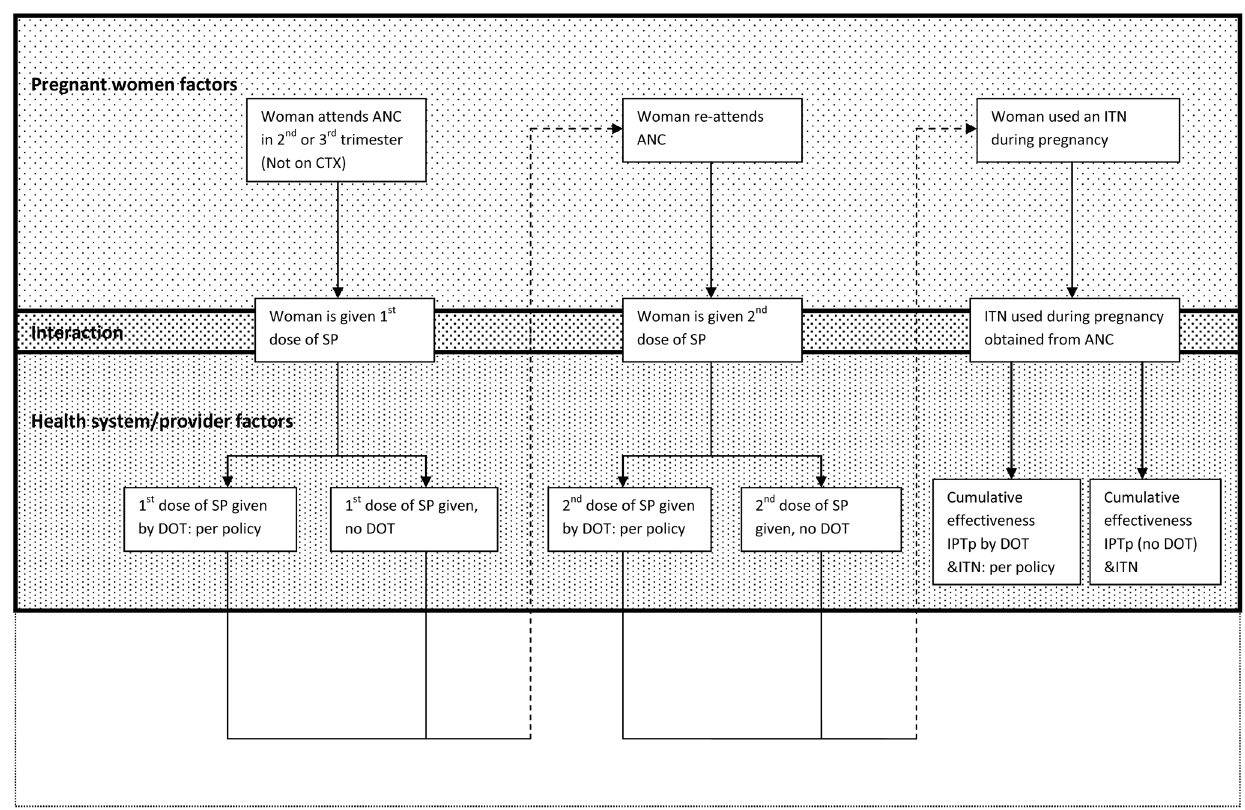
Figure 1. Algorithm for cumulative systems effectiveness of ANC, IPTp and ITN use. ANC: antenatal clinic; CTX: cotrimoxazole; SP: sulphadoxine-pyrimethamine; DOT: directly observed therapy; IPTp: intermittent preventive treatment; ITN: insecticide treated net.